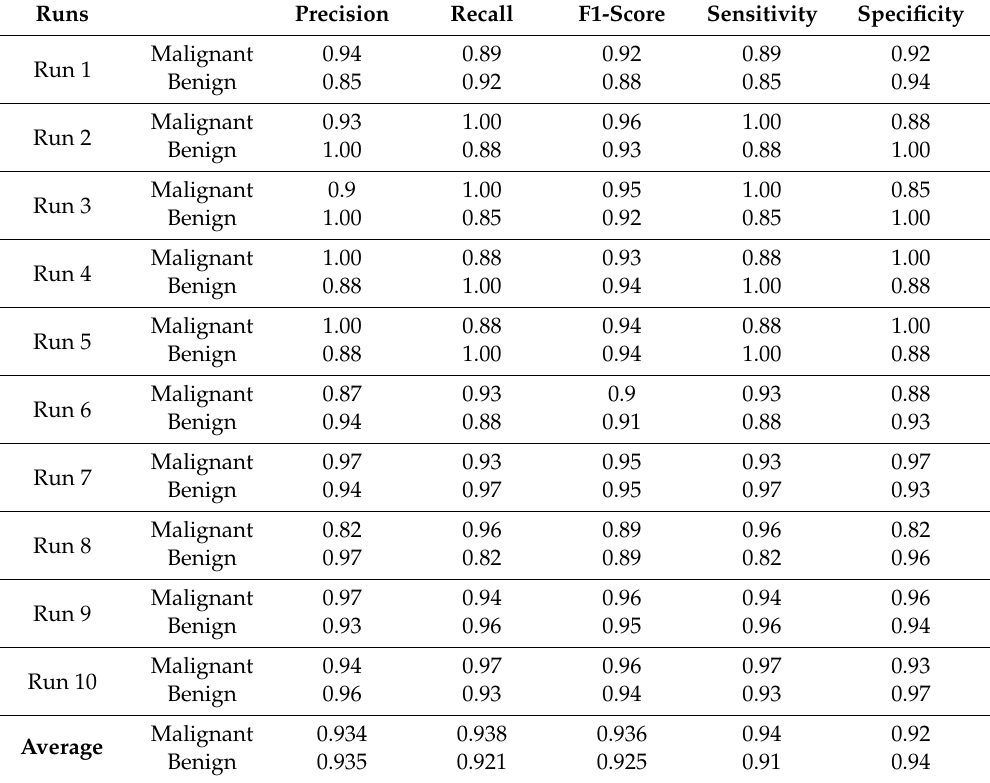
Table 7. Performance metrics for the best CNN for 10 runs (batch size = 8, dropout = 0.7).